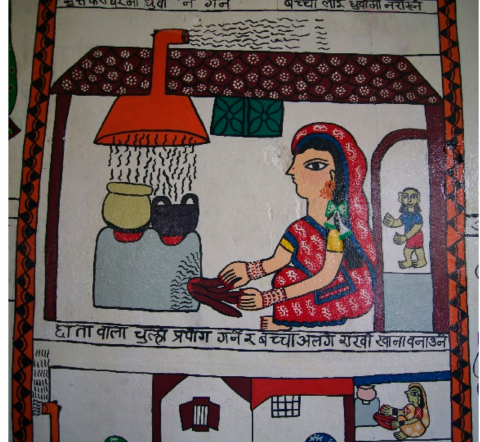
Figure 2. The perceived impact of air pollution on children and the need to keep them away from the cooking. Translation: Figure 2 = “Use of an umbrella-type exhaust above the cooking stove and keeping the child away”. This picture describes ways to reduce air pollution exposure. It shows an improved stove that has a chimney taking the smoke away and a child being kept in a different room.